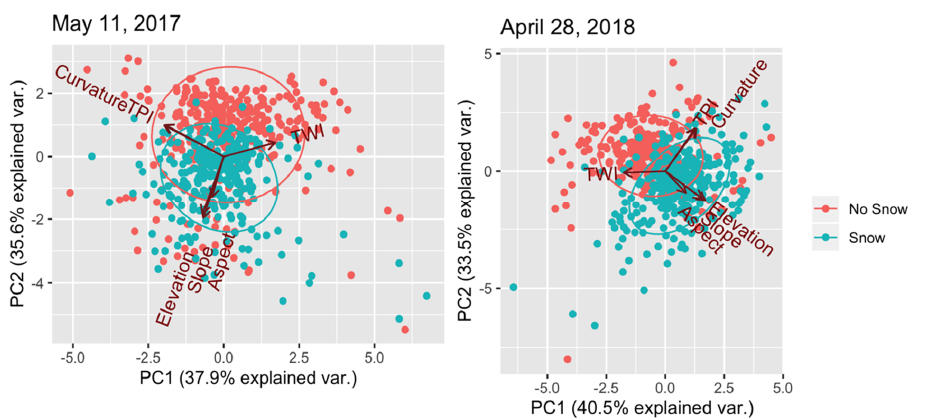
Figure 11. Late spring snow presence and absence on May 11, 2017 and April 28, 2018 in relation to slope, elevation, aspect, topographic wetness index, topographic position index and curvature. Aspect is calculated here as the absolute angle from south (0) to north (180), with no distinction between east and west. The length of each vector represents the loading of each variable on each principal component and the angle between each pair of vectors indicates the correlation between variables. Vectors with the same direction are positively correlated, while vectors with opposing directions are negatively correlated. Ellipses show the distribution of each variable.